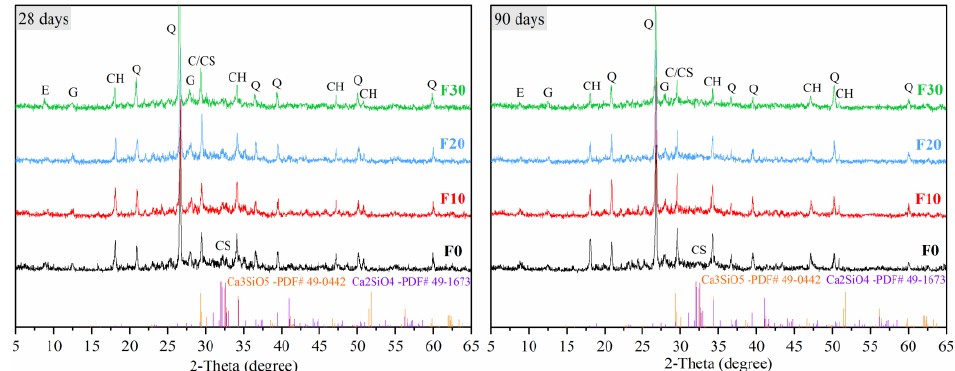
Figure 10. XRD after steam curing. E – Ettringite; CH – Portlandite; Q – Quartz; C – Calcite; CS – C 3 S/C 2 S; G – Gismondine.